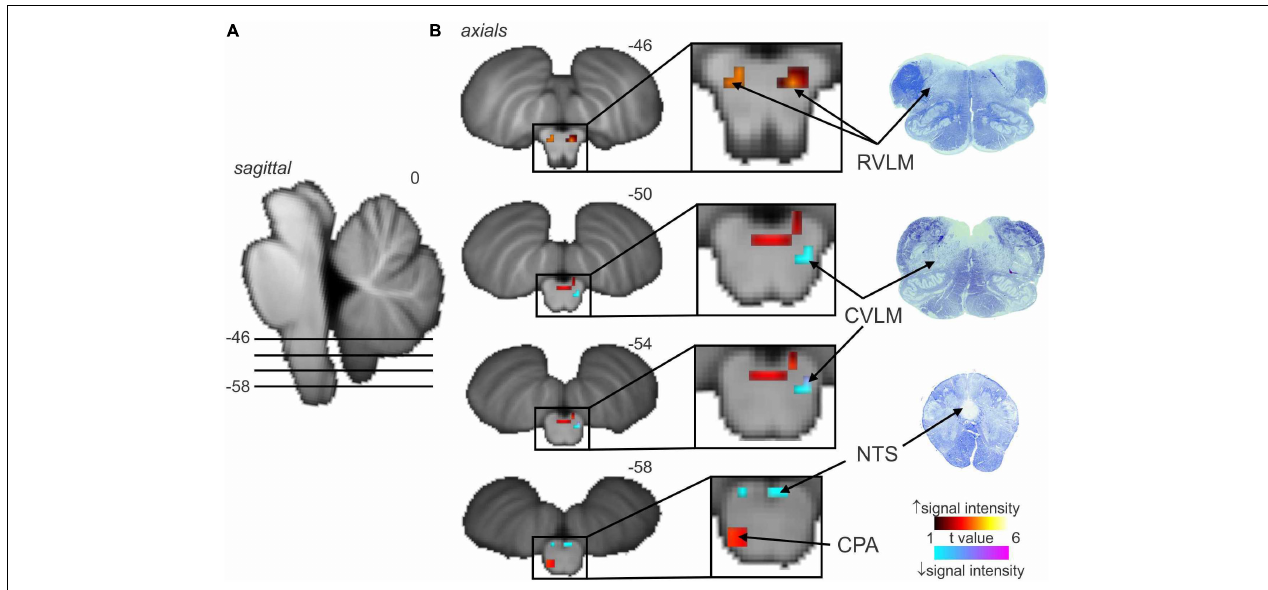
FIGURE 2 | Significant increases (warm color scale) and decreases (cool color scale) in functional magnetic resonance imaging (fMRI) signal intensity within the brainstem correlated with spontaneous muscle sympathetic nerve activity (MSNA; total burst activity) in the resting state; data from seven experiments. (A) Significant changes are overlaid onto sagittal and axial slices of a T1-weighted brainstem template, with slice locations in Montreal Neurological Institute space indicated at the top right of each slice. (B) Equivalent histological sections. Note that spontaneous bursts of MSNA are associated with increases in signal intensity in the regions of the rostral ventrolateral medulla (RVLM) and caudal pressor area (CPA) and decreases in the region of the caudal ventrolateral medulla (CVLM) and nucleus tractus solitarius (NTS). Reproduced, with permission, from Macefield and Henderson (2019).